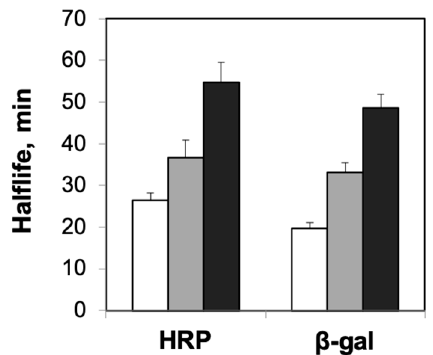
Figure 1. Thermal stability of horseradish peroxidase (HRP) and β -galactosidase ( β -gal) encapsulated in agarose gels. Estimated half-lives of solution-phase enzymes (white bars) and enzymes encapsulated in 0.5% agarose (gray bars) and 2% agarose (black bars) at elevated temperatures. Error bars indicate the standard deviation of triplicate measurements.